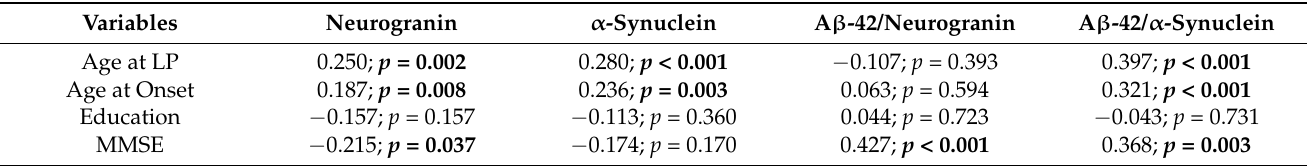
Table 5. Spearman’s correlations of CSF neurogranin and α -synuclein levels, and A β -42/neurogranin and A β -42/ α -synuclein ratios with demographic and clinical features of AD